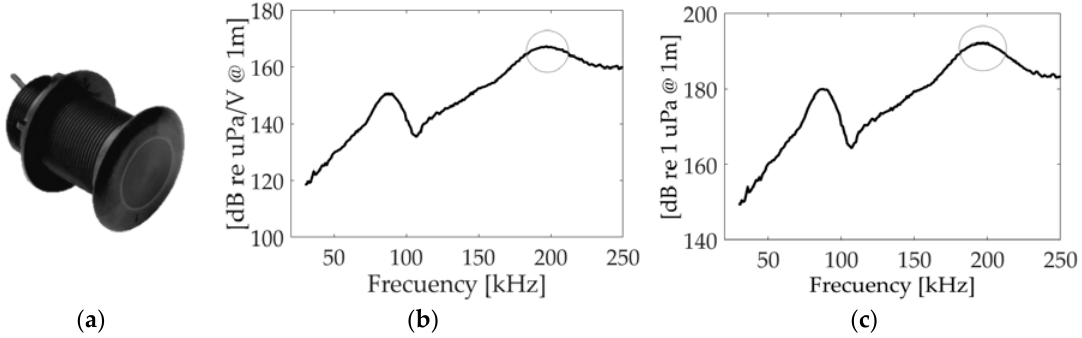
Figure 2. Airmar P19. ( a ) Picture; ( b ) Transmitting Voltage Response (TVR); ( c ) SPL, highlighting the interesting 200 kHz region for this application.